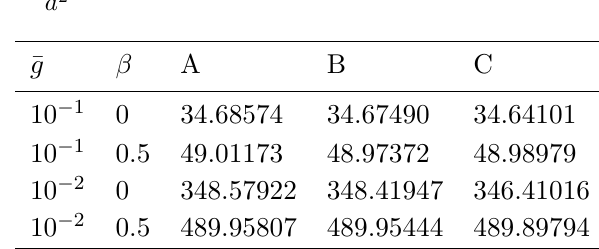
Figure 9 . Dimensionless position dispersion for (a) compactified and (b) uncompactified coordi- nates, with different values for the parameter ¯ g and the quasiperiodicity parameter β . Here we h (∆ x i ) 2 i β ren define h (∆¯ x i ) 2 i β :=